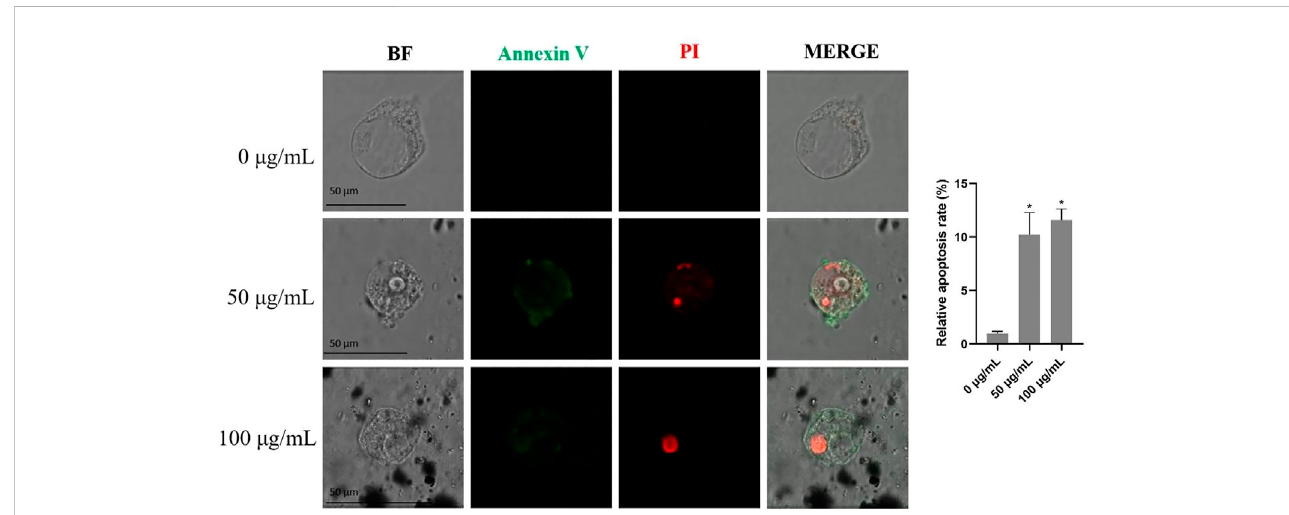
FIGURE 6 Cell apoptosis induced by TWPs in hAOs was detected by Annexin V-FITC/PI staining. Green fl uorescence and red fl uorescence represent early and late apoptotic cells, respectively. Scale bar, 50 μ m.